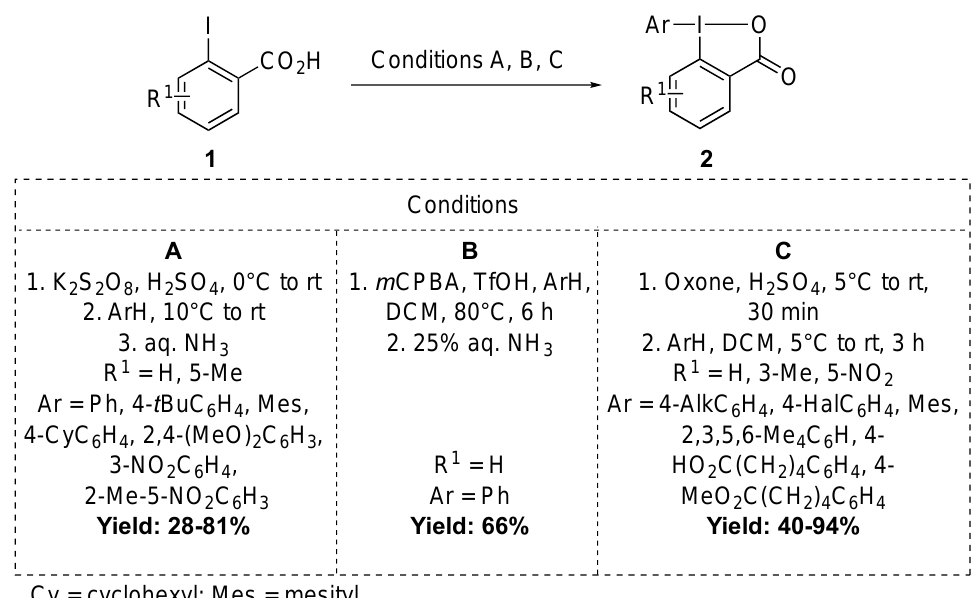
Figure 1. Arylbenziodoxoles, ethynylbenziodoxoles, and vinylbenziodoxoles.